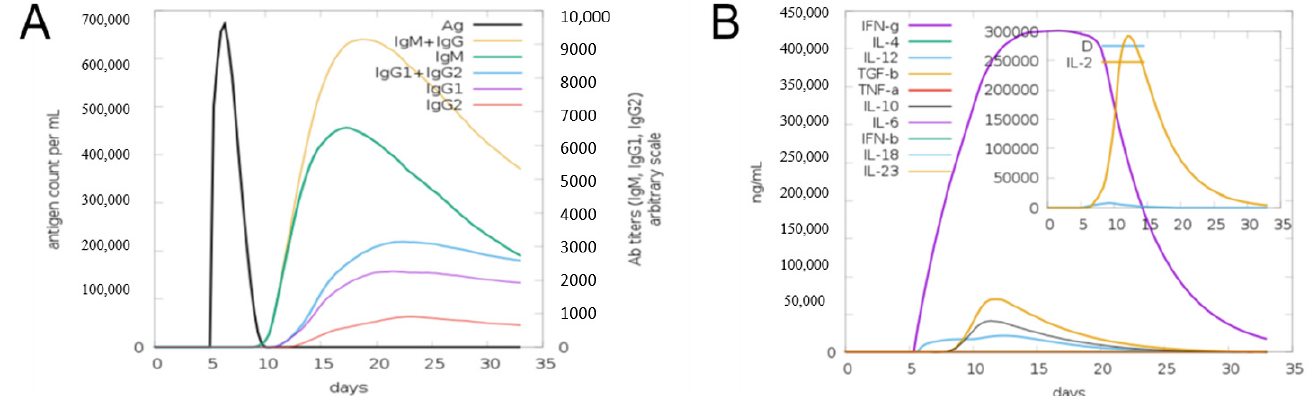
Figure 9. Computational immune simulation of the host immune systems obtained in response to the action of the original design of the vaccine. ( A ) The production of immunoglobulins in response to the originally designed vaccine can be seen. ( B ) Graph depicting the activation of the immune system, as the interleukin and IFN-g production can be observed.